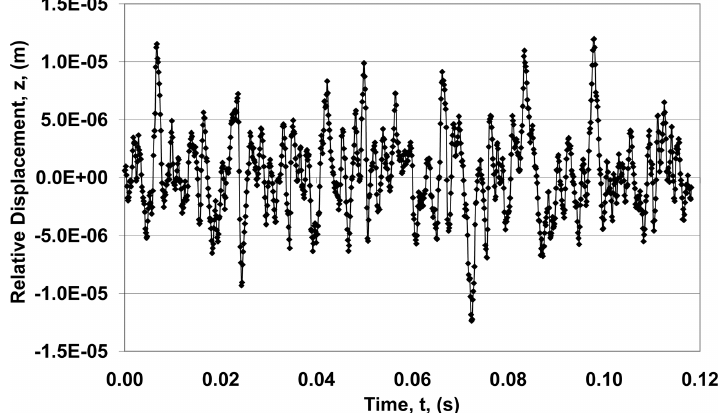
Fig. 6. Displacement response in the time domain, Prototype M .